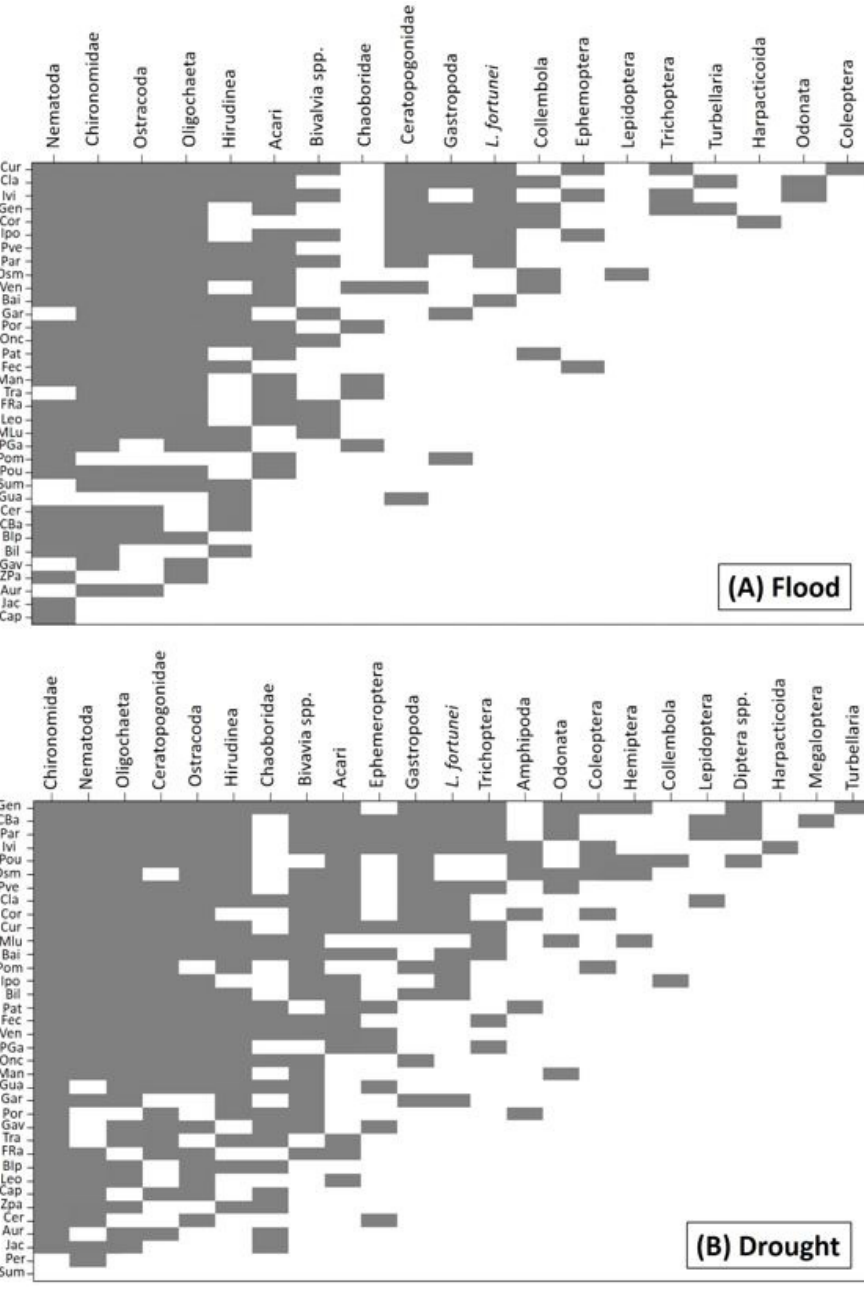
Figure 4. Benthic invertebrates nestedness among the habitats during the flood (A) and during the drought (B). Grey rectangles represent taxa